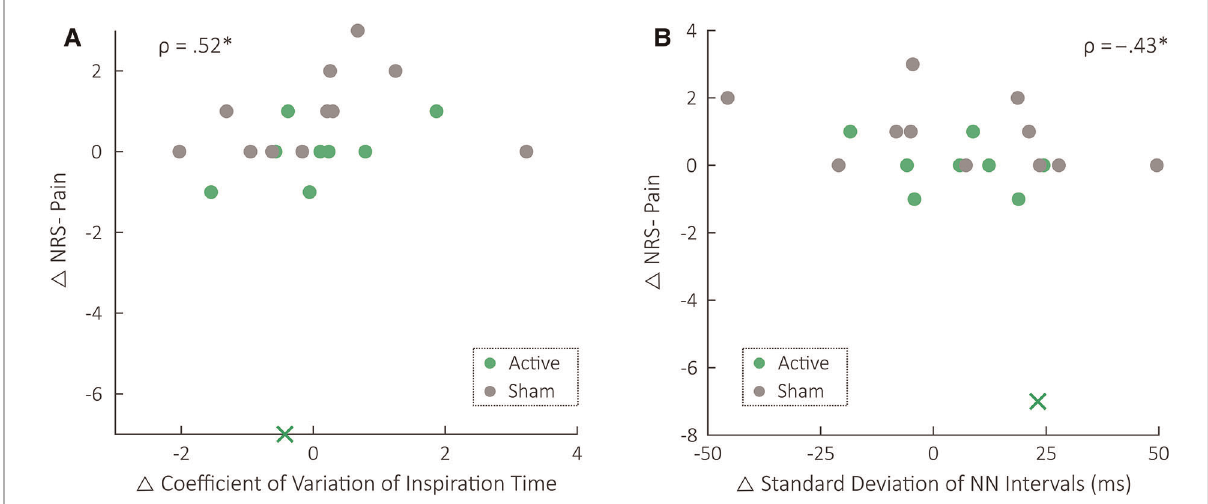
FIGURE 4 Plots of Δ NRS pain vs. Δ RPV and Δ HRV across all patients. The Spearman correlation values, ρ , are shown following adjustment for device group (i.e., active vs. sham). Gray is used to depict the sham group ’ s datapoints, and green is used to depict the active group ’ s datapoints. x indicates the outlier datapoint, and * indicates P <0.05. (A) Plot of Δ NRS Pain vs. Δ coef fi cient of variation of inspiration time [CV(T i )]. Note that CV(T i ) is unitless. (B) Plot of Δ NRS Pain vs. Δ standard deviation of Normal-to-Normal intervals (SDNN).